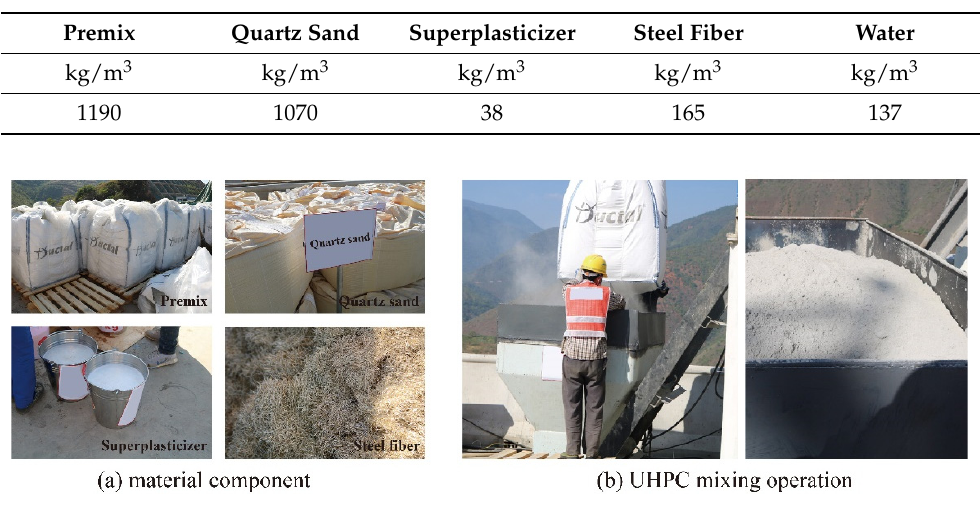
Figure 3. Material component and mixing operation of UHPC.